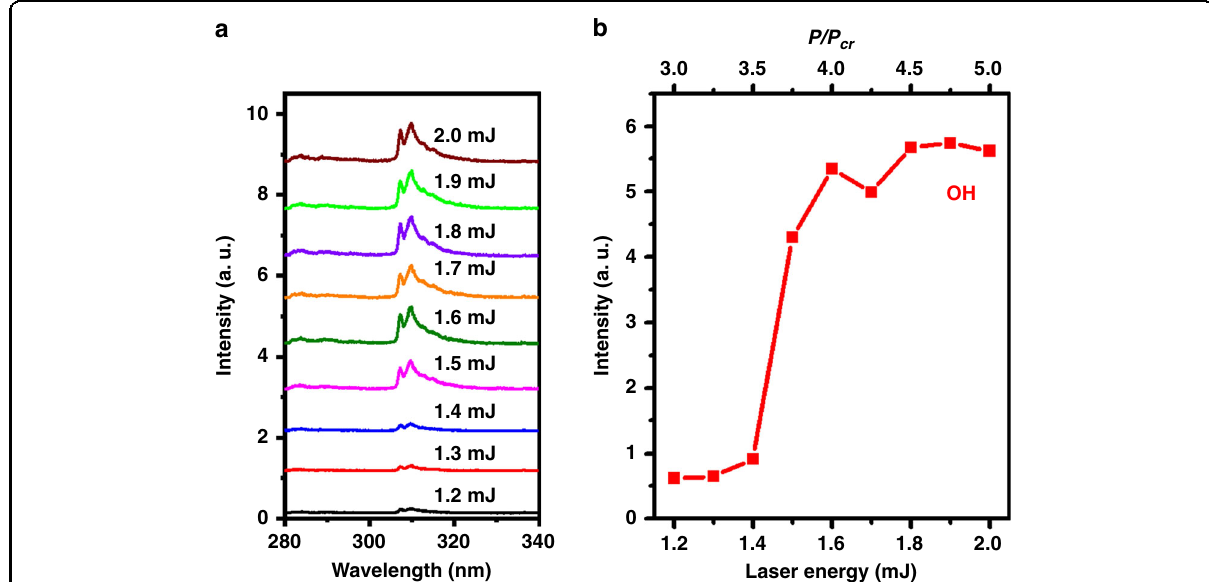
Fig. 5 OH radical fl uorescence measurement. a Emission spectra at 50 ns after the laser arrives with a time integration of 100 μ s in a CH 4 /air fl ow at different energies. b OH emission intensity with different incident laser